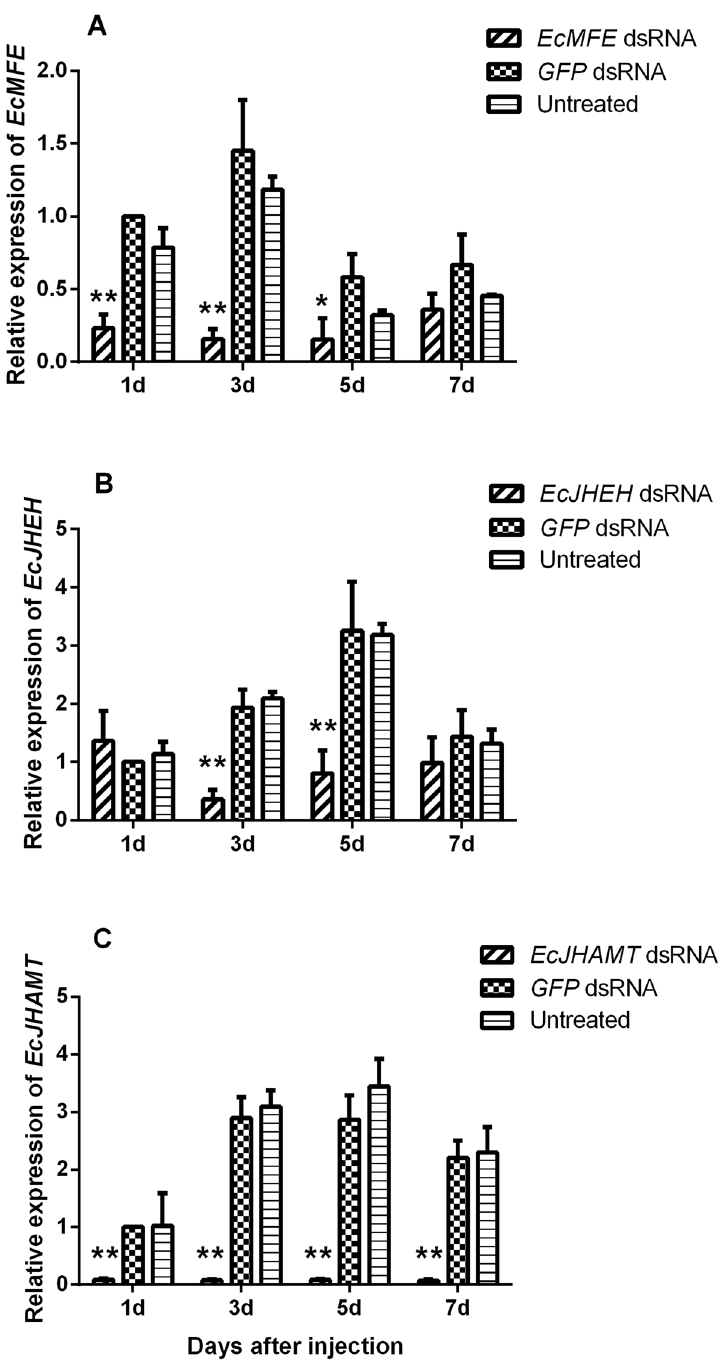
Figure 3. Relative expression profiles of genes in male E. chinensis at different times after dsRNA injection. ( A ) EcMFE . ( B ) EcJHEH . ( C ) EcJHAMT . Asterisks above represent statistically significant differences by Student’s t -test ( * P < 0.05; ** P <